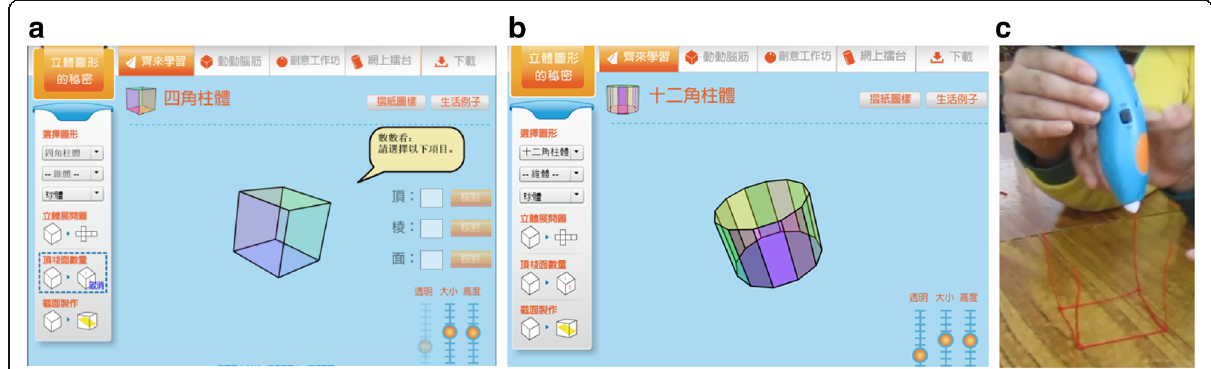
Fig. 1 a , b A computer applet that performs virtual transformations of various 3D figures. c Constructing a physical artefact (i.e. a cube) with a 3D